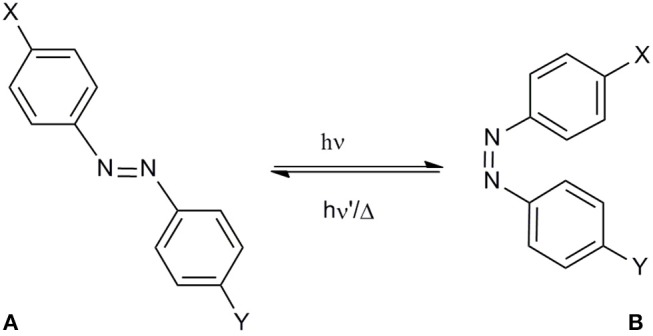
(A) azopeptide 1 (X = T-P-R-V-E-R-;Y = T-V-F-L-A-P-Y-G-W-M-V-K); trans-(4-aminomethyl)phenylazobenzoic (AMPB) acid (X = CH2NH2,Y = CH2COOH) 2; trans-azobenzene (X,Y = H) 3, (B) their possible cis conformation.